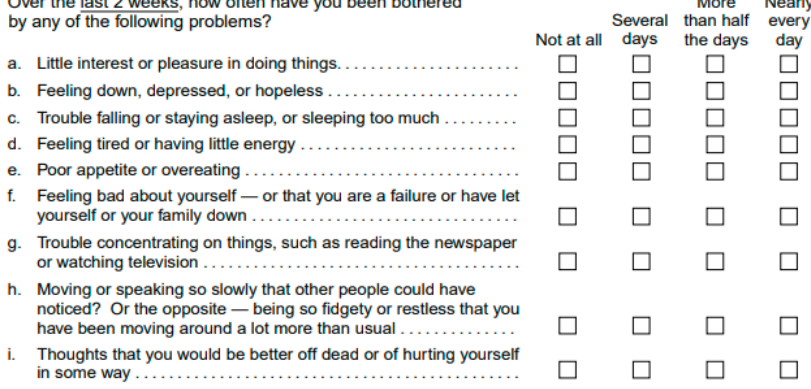
Figure 1. Patient Health Questionnaire-9 (PHQ-9).